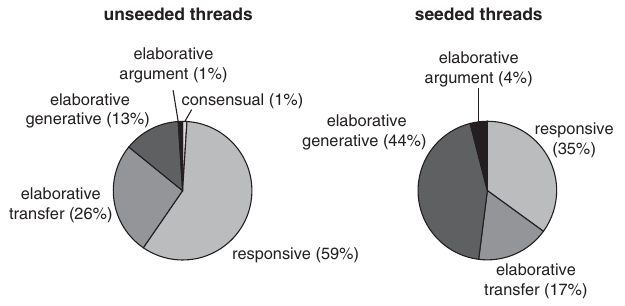
FIG. 6. Percentage of thread types in unseeded versus seeded sections.